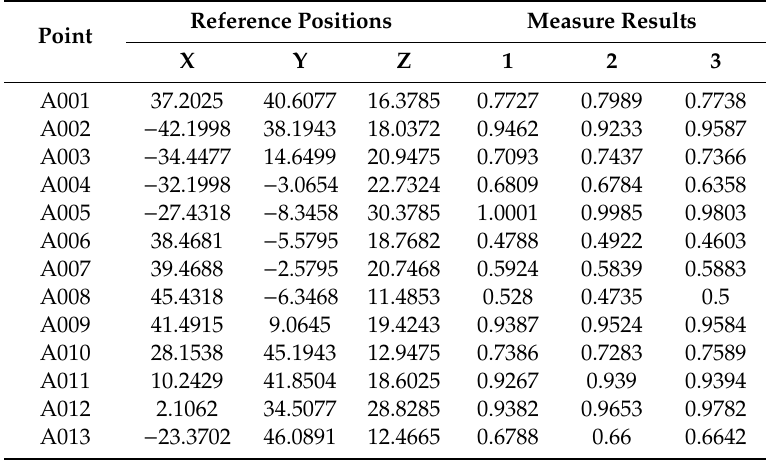
Figure 16. Measurement results. Table 7. Measurement